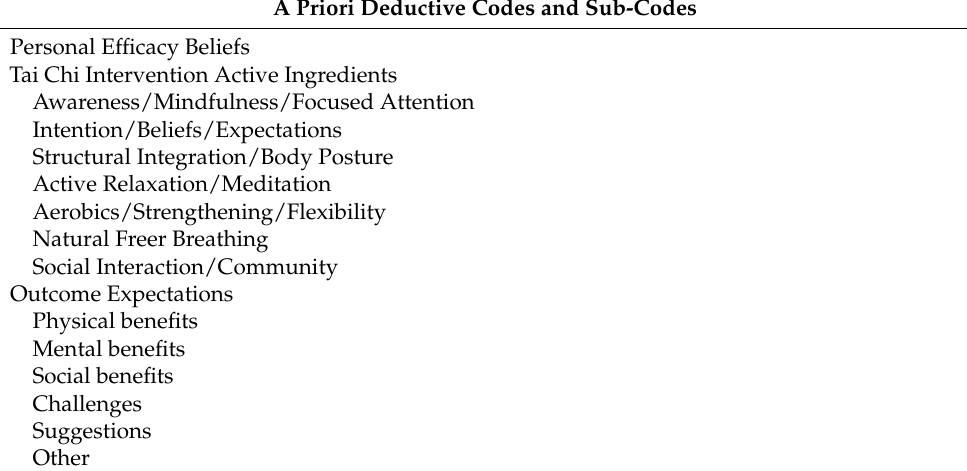
Table 1. A-Priori Deductive Codes and